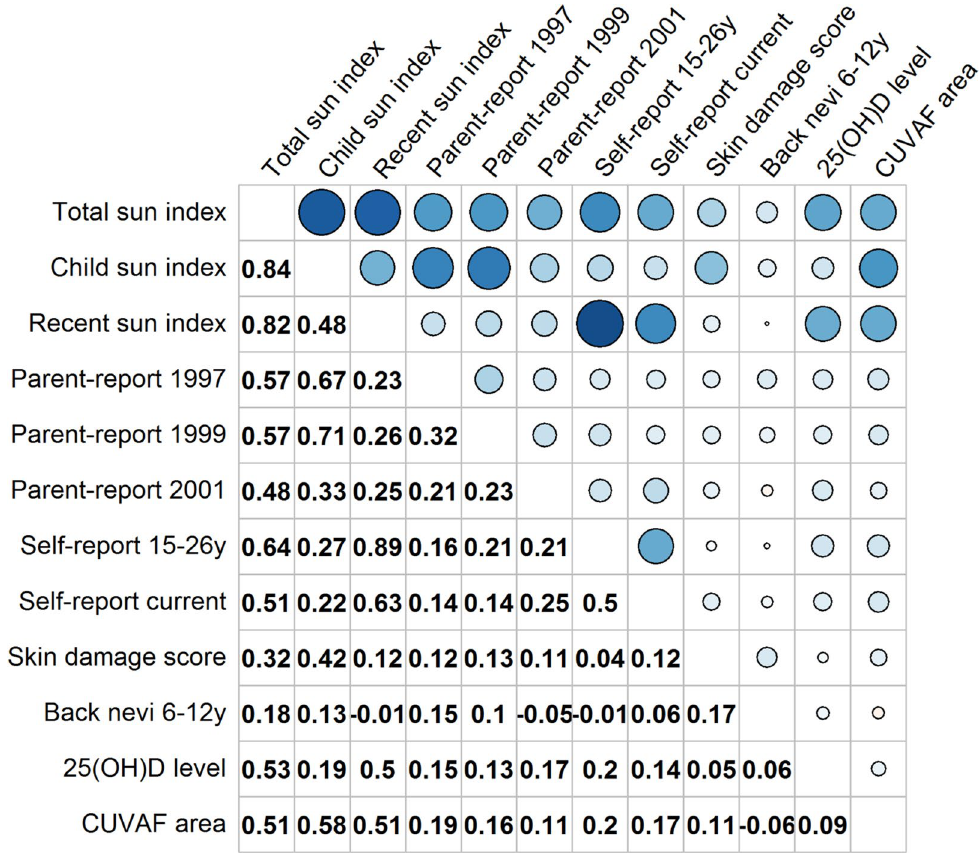
Figure 2. Correlation between each of the sun-exposure indices and observed measures of sun exposure. Pearson correlation coefficient is presented in lower half of table; correlations involving skin damage score are the polyserial correlation coefficient due to the ordinal nature of skin damage score. In the upper half, the size and darkness of the circles represent the strength of the correlation with larger and darker circles representing a higher correlation coefficient. All correlations ≥ 0.13 are significantly greater than 0 (i.e. p < 0.05). 25(OH) D 25-hydroxyvitamin D, CUVAF conjunctival ultraviolet autofluorescence. Figure drawn using the